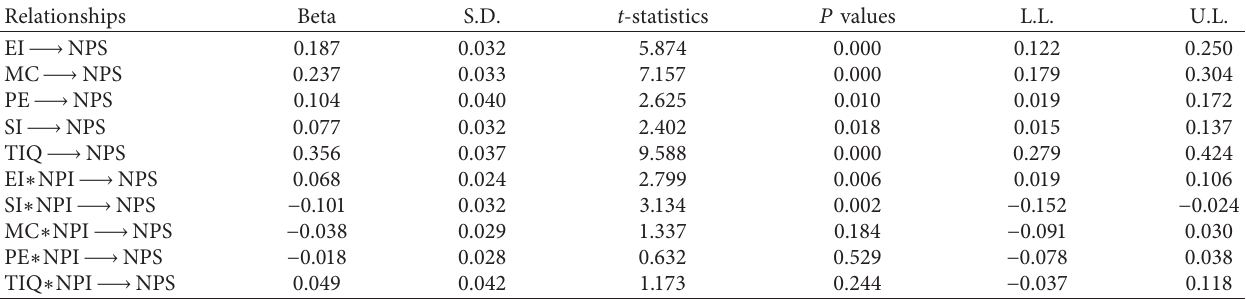
Table 5: Path analysis.